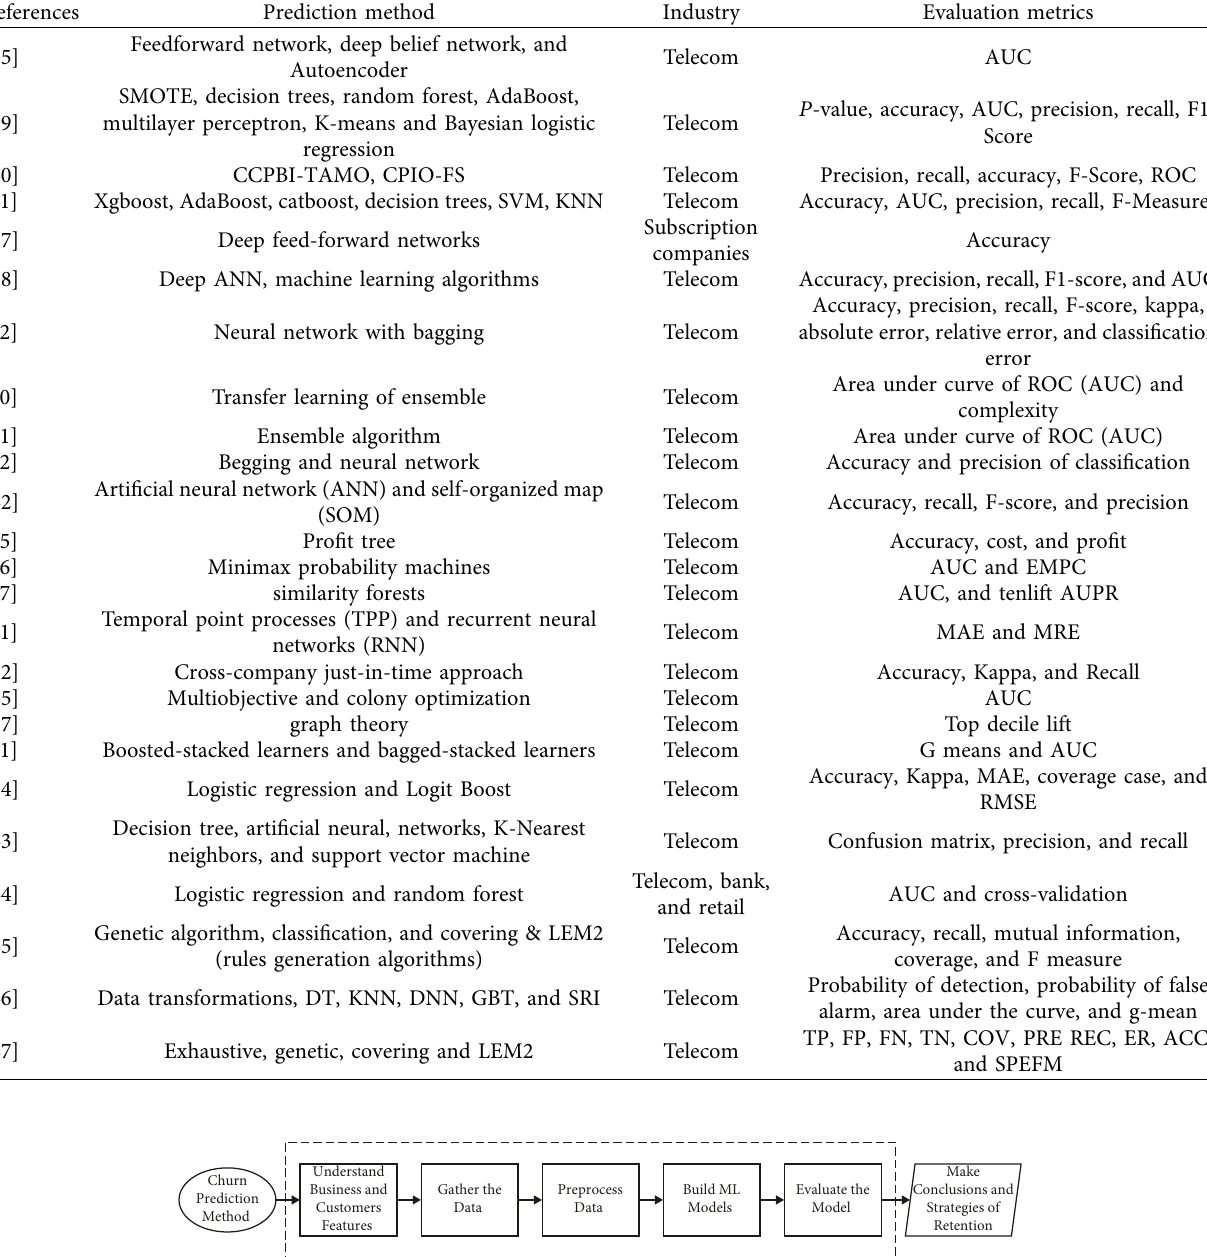
Table 1: Literature review summary.